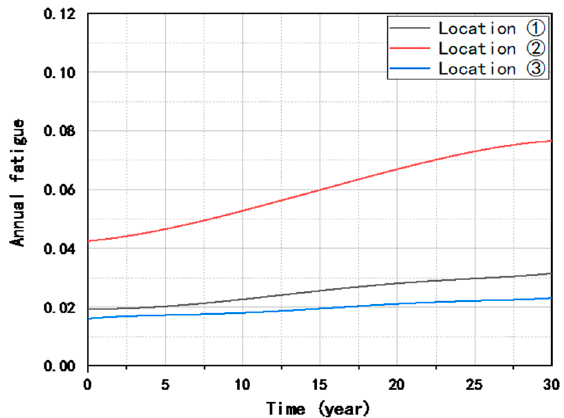
Figure 10. Accumulated fatigue damage of tubular joints under the combined loads obtained by the equal-amplitude load method.